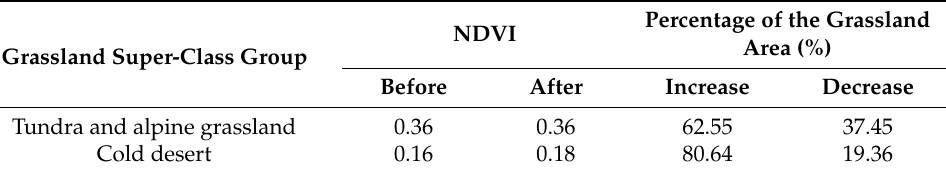
Table A3. The statistical description of the annual average NDVI before (2004–2010) and after (2011–2017) the implementation of the